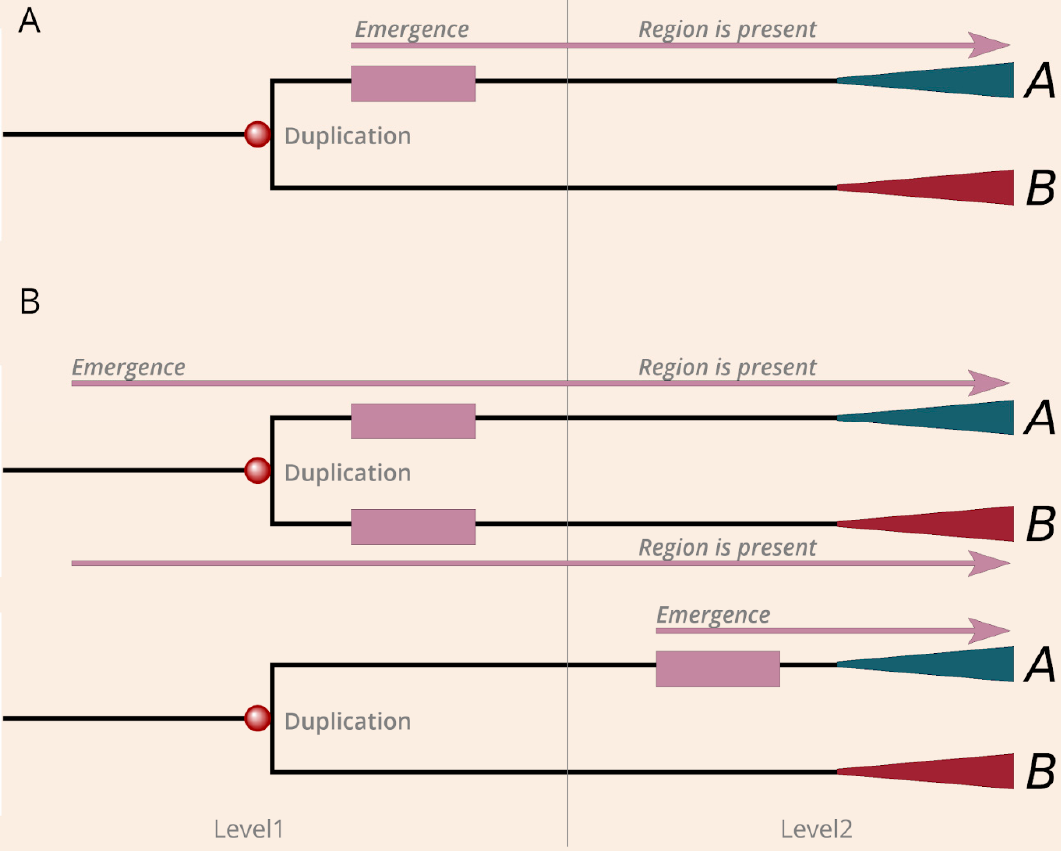
Figure 3. The mechanisms of emergence of regions by neofunctionalization and de novo. ( A ) Demonstration of the model of duplication induced (neofunctionalization) cancer region emergence. ( B ) Depiction of the two sub-scenarios of the de novo region emergence. Mallow boxes and arrows explain the evolution of the region. Red and green triangles symbolize the further evolution of paralogs after gene duplications.